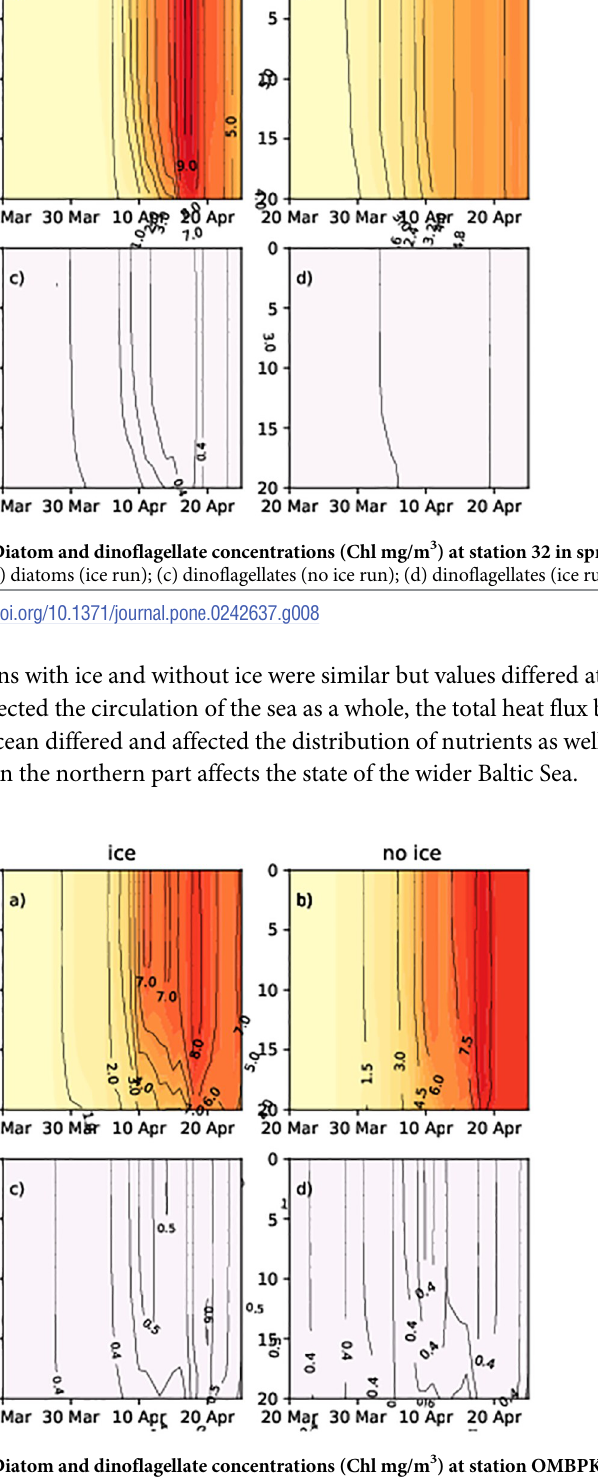
Fig 9. Diatom and dinoflagellate concentrations (Chl mg/m 3 ) at station OMBPK3 in spring 2013. (a) Diatoms (no ice run); (b) diatoms (ice run); (c) dinoflagellates (no ice run).